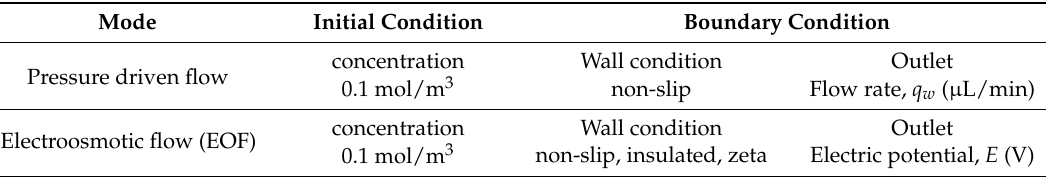
Table 2. Key boundary condition and initial condition applied in the simulations of micro mixing in pressure driven flow and EOF.